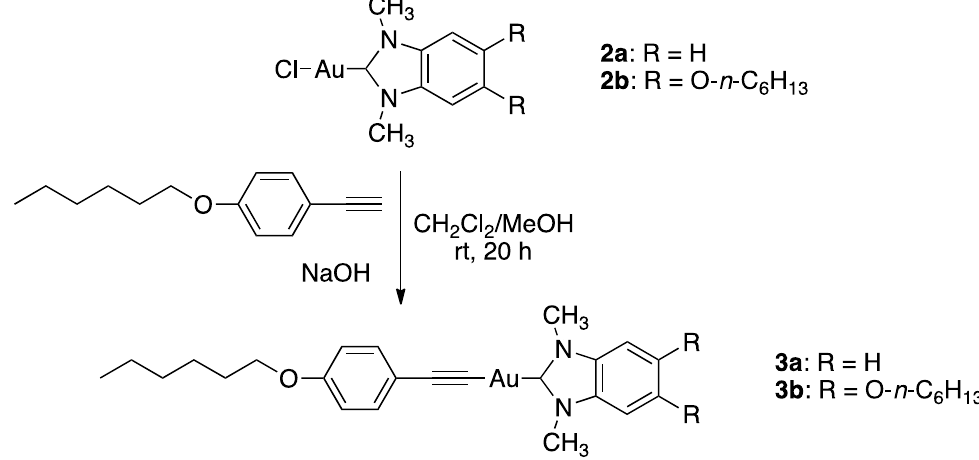
Figure 1. Molecular structure of gold complexes used in this